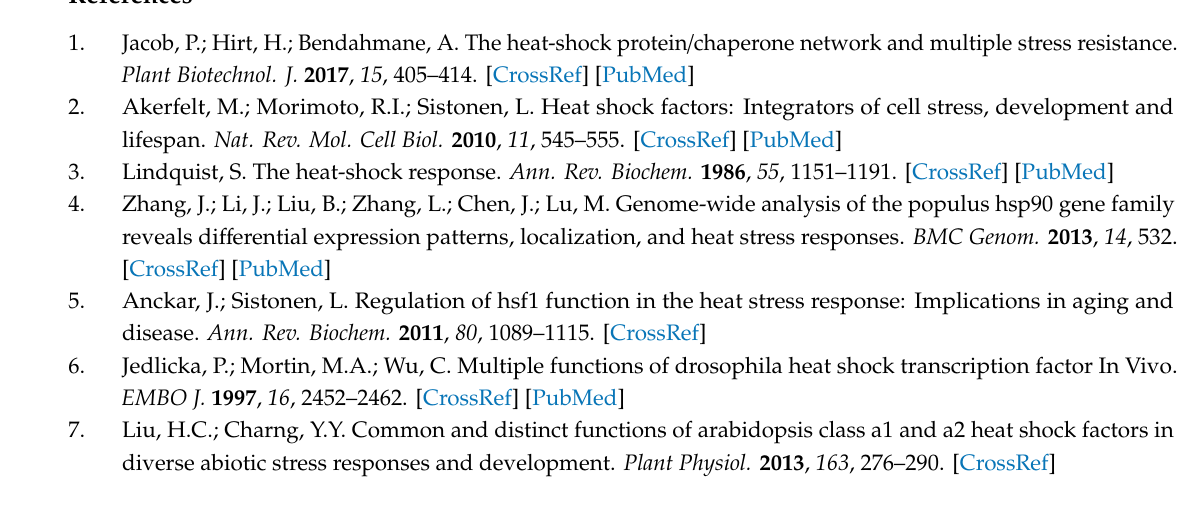
Figure S1. 3D structures comparison of paralogous pairs from PtHsf family. Figure S2. Two paralogous pairs protein sequence alignment analysis. Table S1. Enrichment analysis of PtHsfs co-expressed genes. Table S2. List of transcription factor genes co-expressed with PtHsfs. Table S3. SNP information of PtHsf gene family. Table S4. protein sequence similarity in Figure